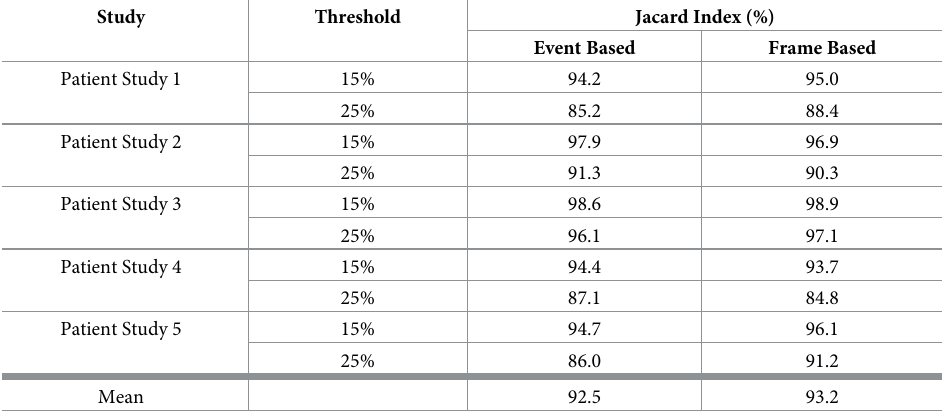
Table 2. Quantitative evaluation of corrected